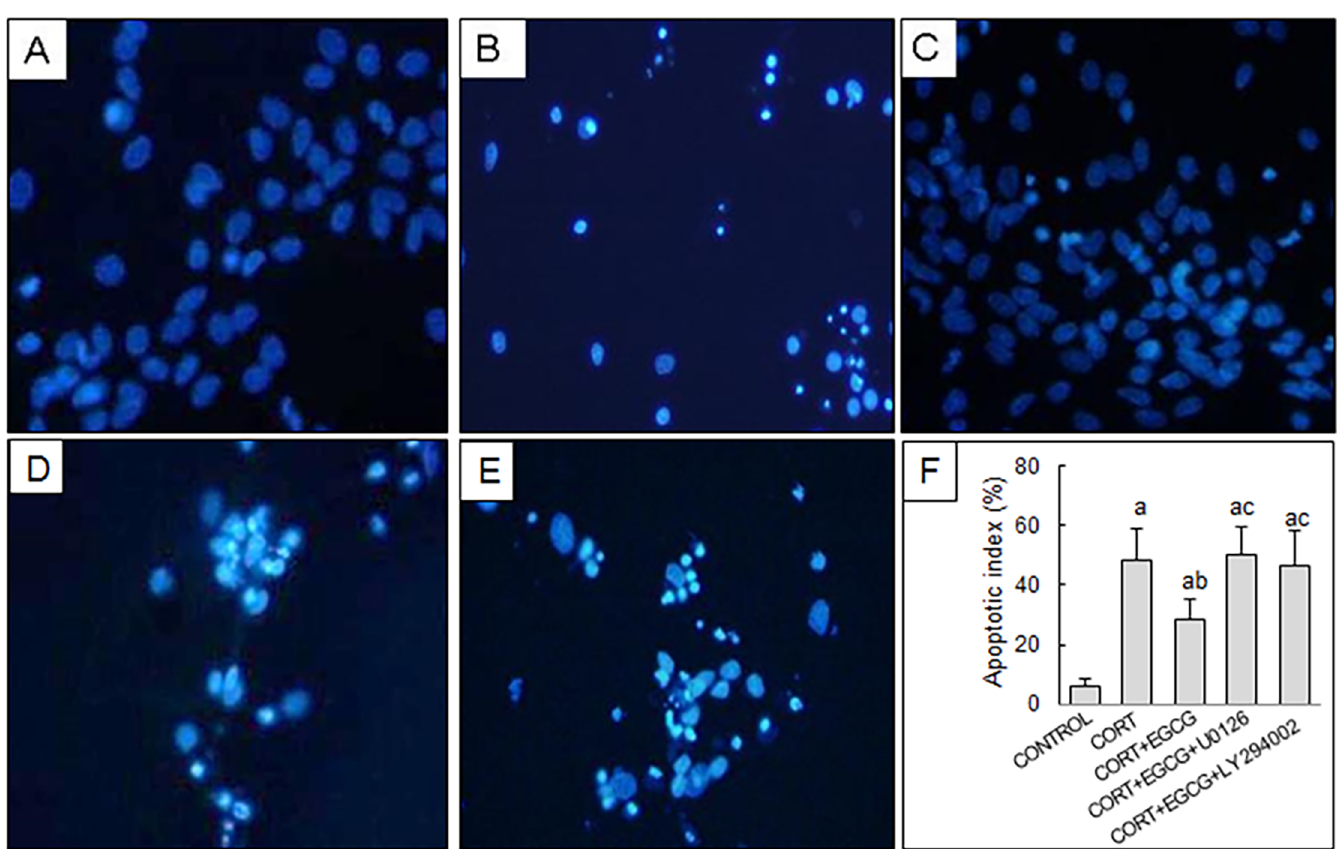
Fig 3. The effect of EGCG on CORT-induced morphological changes of hippocampal neurons by Hoechst 33342 staining. Primary hippocampal neuron cultures were treated with CORT for 24 h in the absence or presence of EGCG pre-treatment (1 μ mol/L, 2 h prior to CORT stimulation), ERK1/2 inhibitor (U0126, 10 μ mol/L) or PI3K/AKT inhibitor (LY294002, 10 μ mol/L) pre-treatment (30 min before CORT exposure). A) Normal control neurons; B) CORT treatment; C) EGCG and CORT co-treatment; D) EGCG+CORT+U0126 treatment; E) EGCG+CORT+ LY294002 treatment; F) The apoptotic index of hippocampal neurons. a P < 0.05 vs Control group: b P < 0.05 vs CORT group; c P < 0.05 vs CORT+ EGCG group.